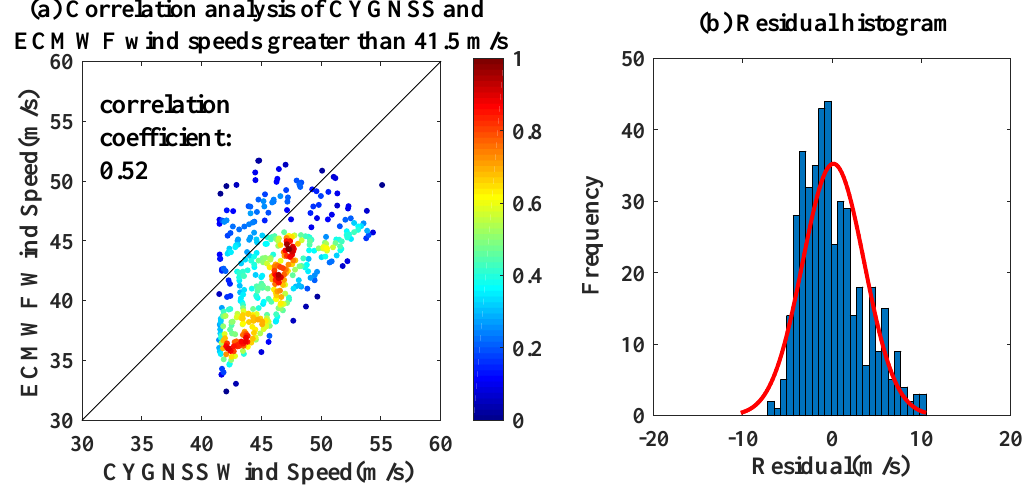
Figure 9. Scatter density plot and residual distribution of CYGNSS and ECMWF wind speeds greater than 41.5 m / s. ( a ) Scatter plot of CYGNSS and ECMWF winds greater than 41.5 m / s; ( b ) CYGNSS and ECMWF wind speed residual distribution histogram. The colors bar (from cool to warm) represents the change of scatter density from small to large values in a given